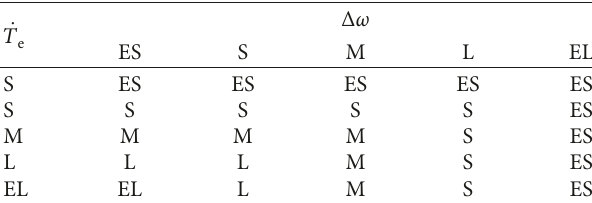
Figure 9: Membership functions of input and output variables. (a) Membership functions of Δ ω ( n ) . (b) Membership functions of _ T (c) Membership functions of λ . Table 2: Fuzzy